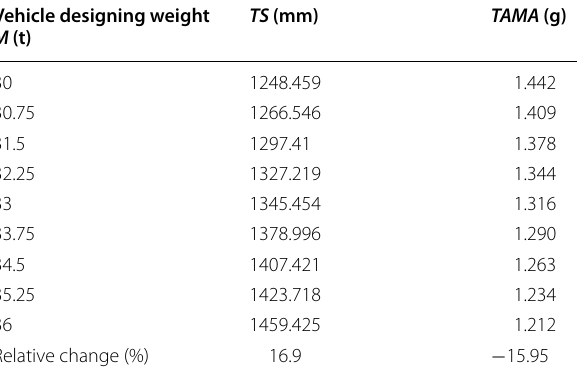
Table 8 Responses of TS and TAMA under different